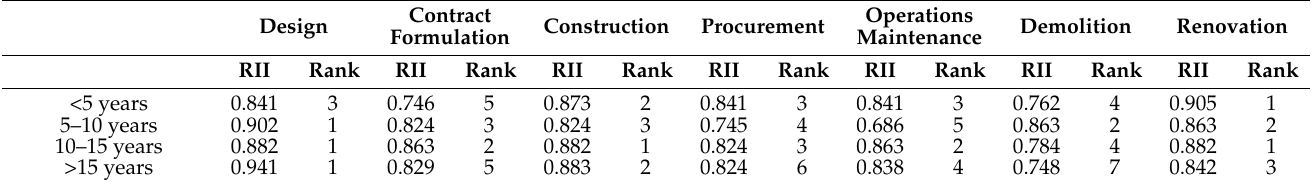
Table 15. Categorized RII ranking of the project phase that the stakeholders mainly relate sustainabil- ity to, based on the respondents’ construction